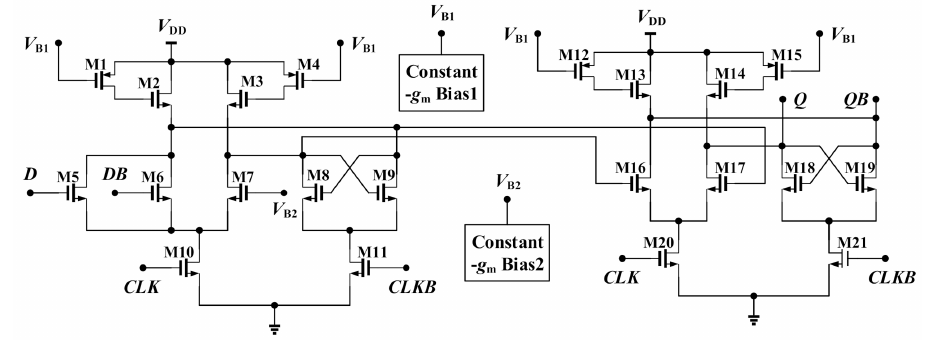
Figure 4. Schematic of the modified DFF based on active inductors integrated with “OR” logic.